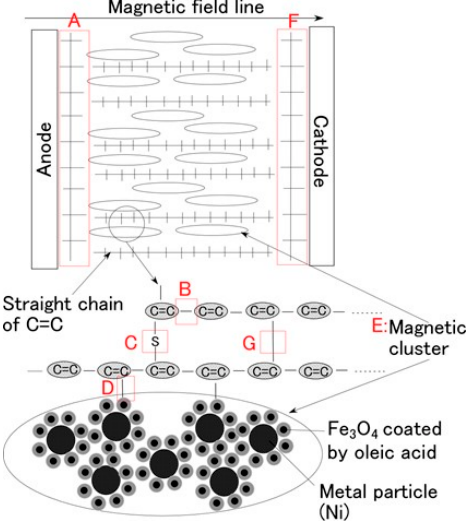
Figure 8. Physical model of electrolytic polymerization of the MCF rubber by the NM [22]. Note that G in the figure was added in the present